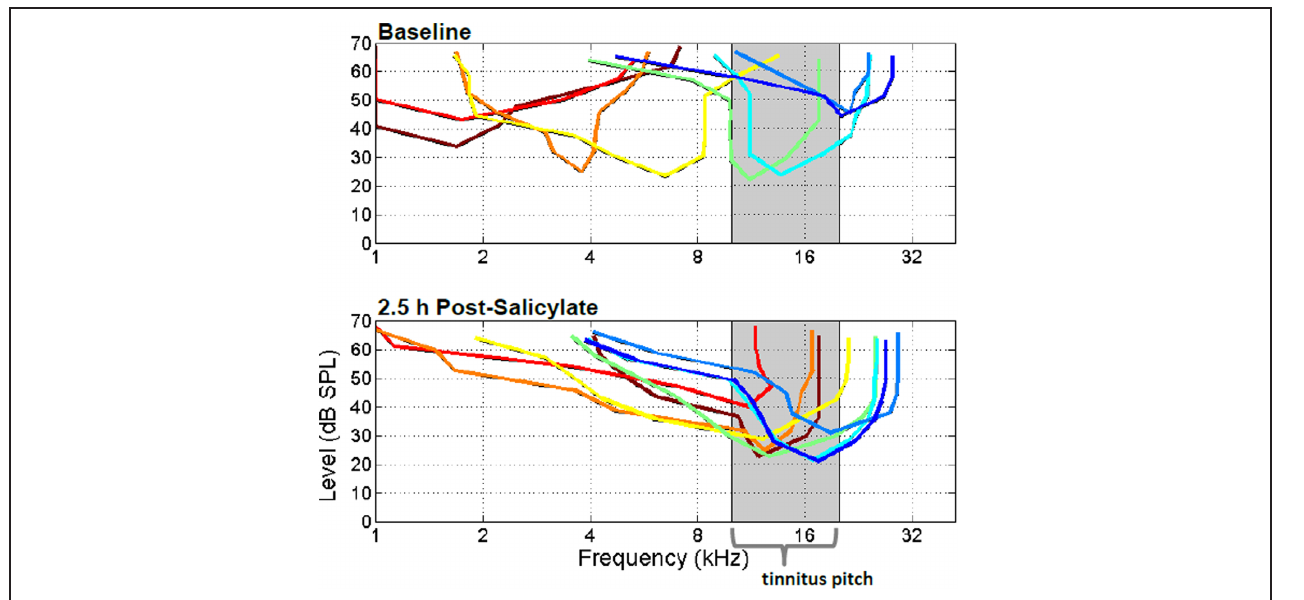
tunings of tracked multiunits shifted maximal frequency sensitivities toward the 10–20kHz frequency region, near the estimated tinnitus pitch. Please see Stolzberg et al., 2011 for population statistics. [From Stolzberg et al. (2011) with